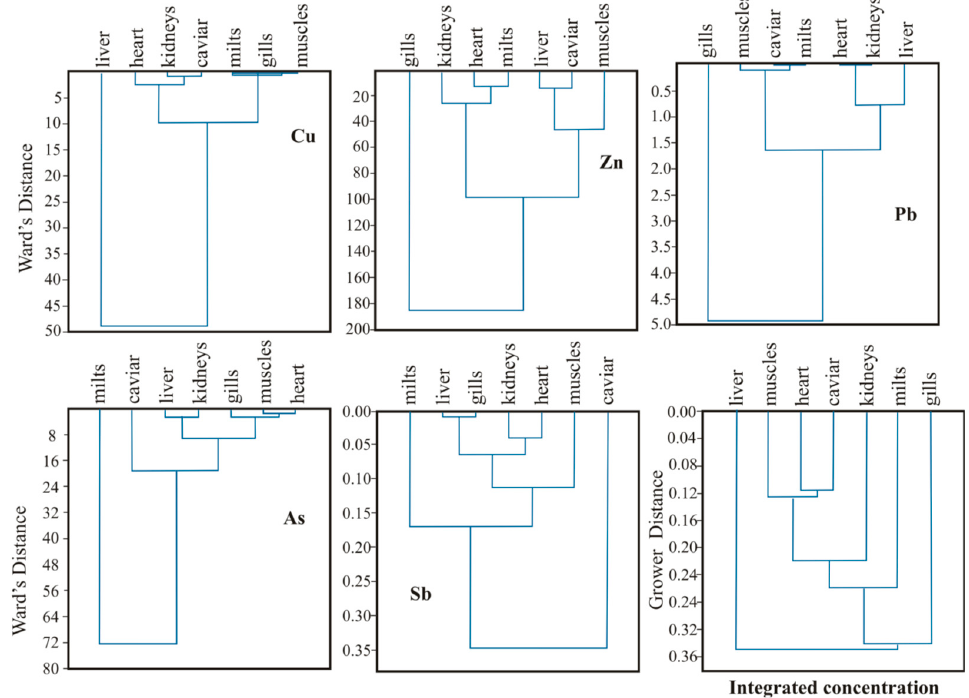
Figure 7. Results of cluster analysis on the distribution of some elements in the organs of carassius.